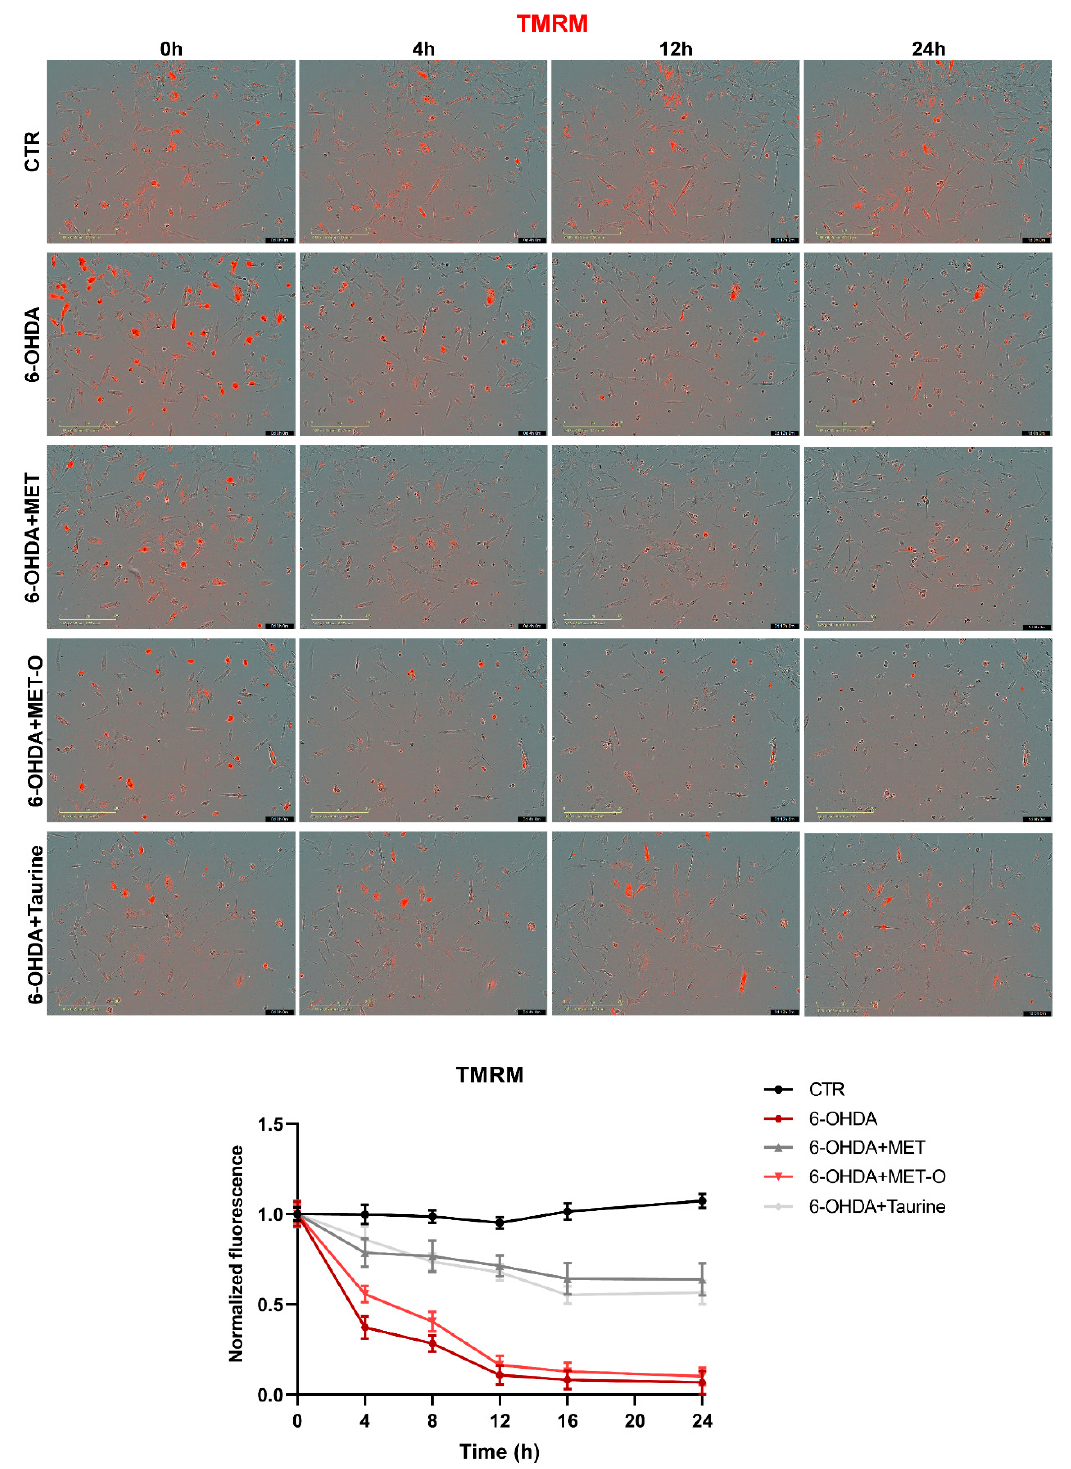
Figure 9. TMRM in live cells by the Incucyte system at 0, 4, 12, and 24 h time points. Representative images and relative normalized fluorescence graph are shown. Data are mean of 3 different experiments ± SD, and the significance is reported in Table S1.